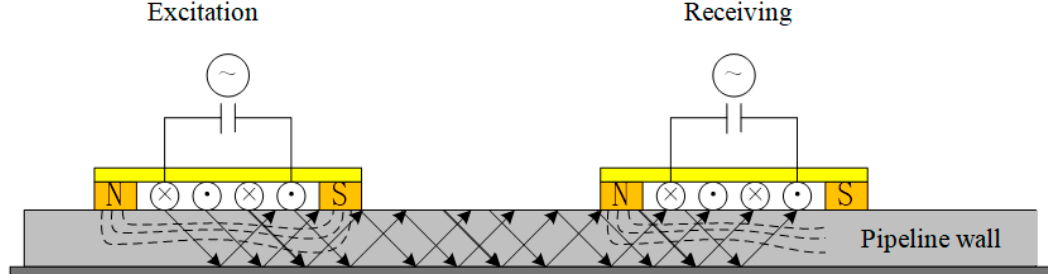
Figure 3. Principles of EMAT inspection.